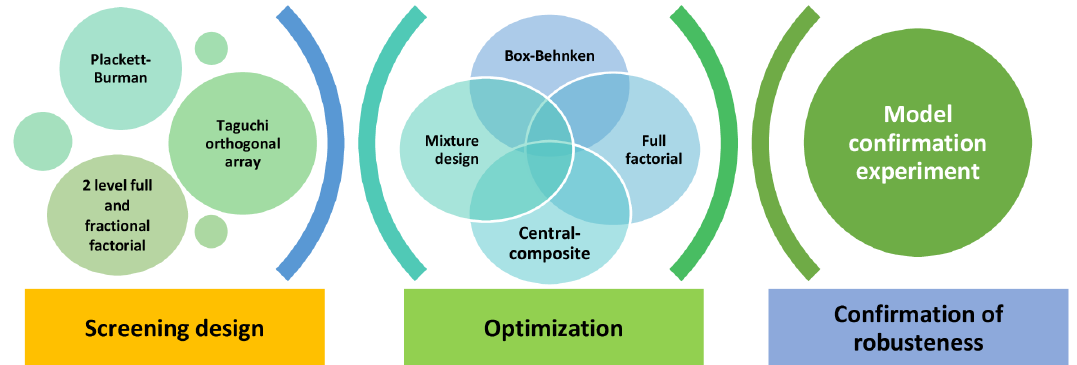
Figure 5. Implementation of DoE into pharmaceutical product